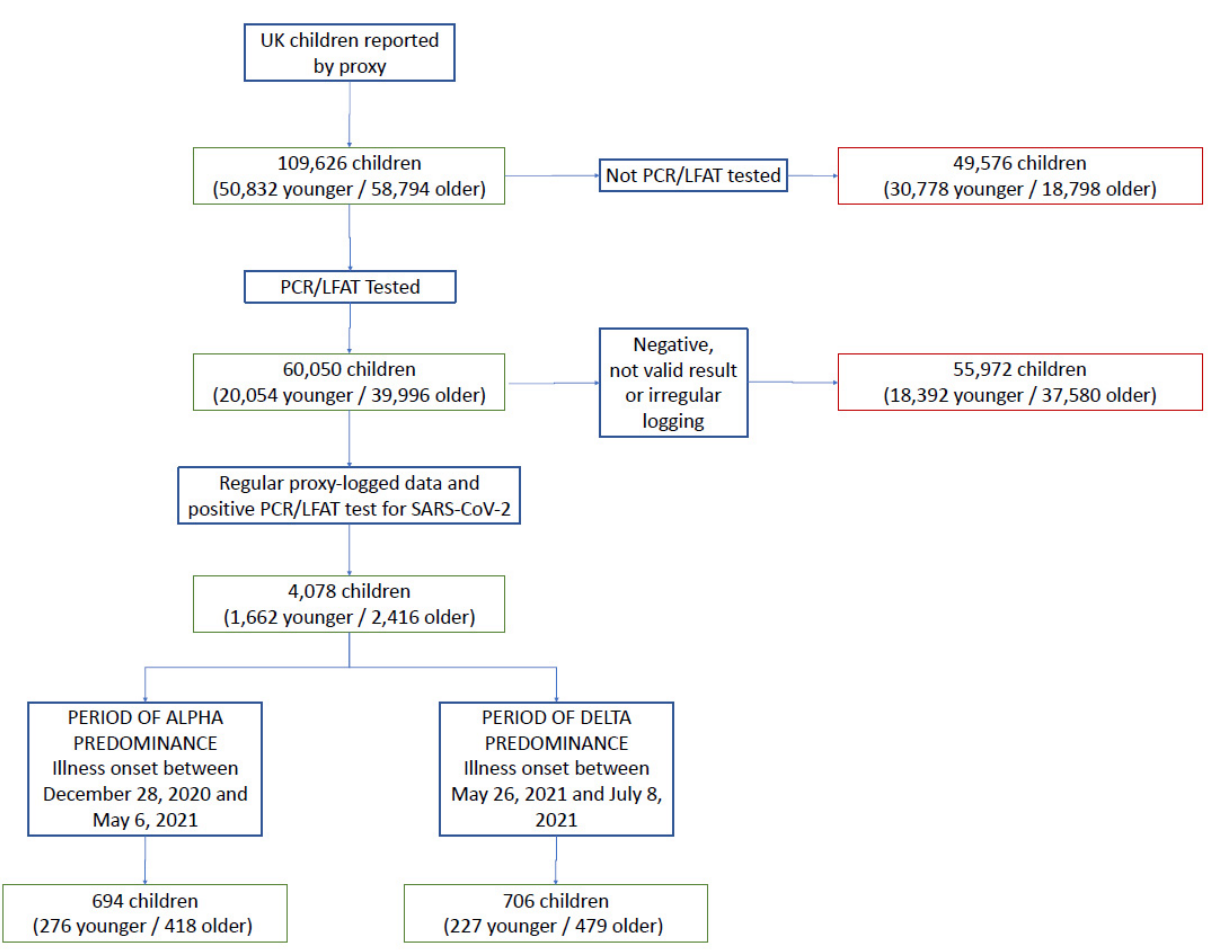
Figure 1. Study flowchart of inclusion and exclusion criteria. Overall number for the entire cohort of children is given first. Younger children = aged 5–11 years (UK primary school-aged children). Older children = aged 12–17 years (UK secondary school-aged children). Not valid result = test result proxy-reported as “failed test” or “still waiting”. Irregular logging = proxy-reporting with intervals of more than 7 days between proxy-reports during